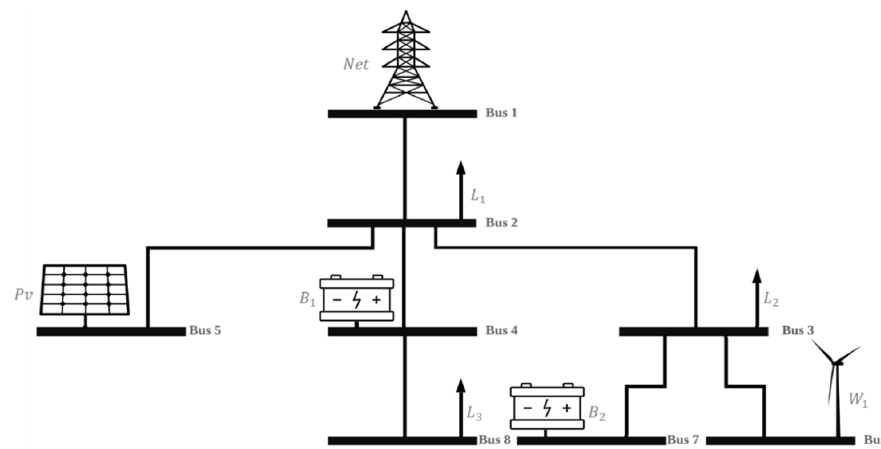
Figure 1. Test system. Taken from [31].